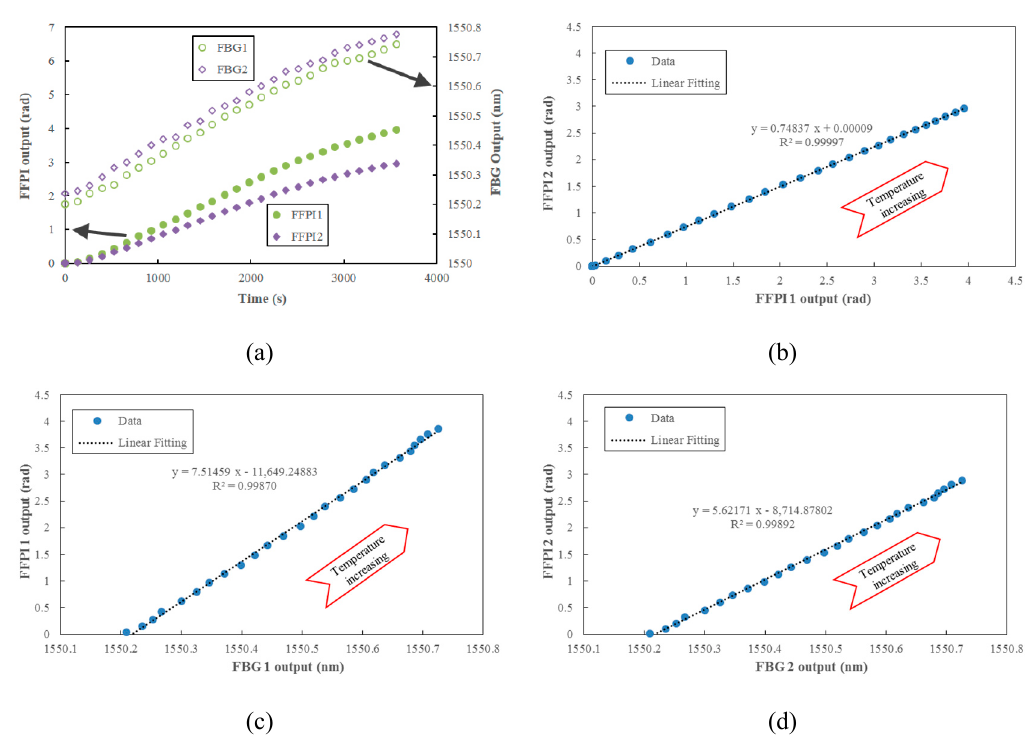
Figure 13. Thermal performances of the FFPIs and FBGs located on the forebody of the balance from room temperature (~25 °C) to 80 °C: temperature outputs with time ( a ), and relationships between different sensors ( b – d ). The higher linear correlation coefficient ( R 2 ) in ( b) –( d) from linear fitting indicates a lower temperature fluctuation between the sensors.